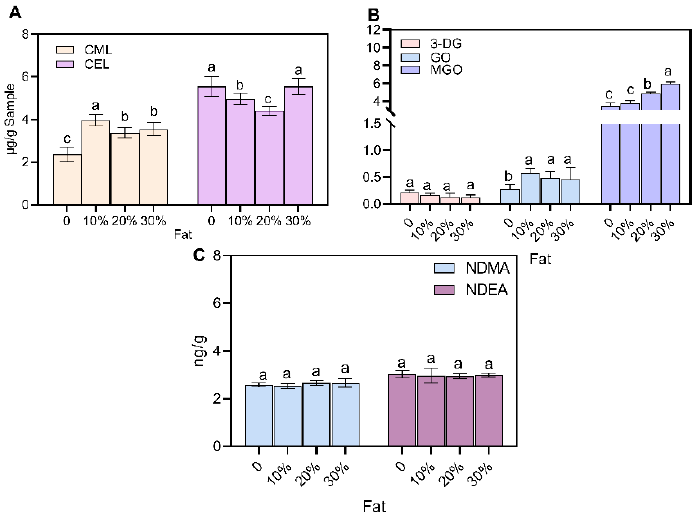
Figure 7. Effect of different ratios of fat addition on AGEs, α -dicarbonyl compounds and NAs: ( A ) AGEs; ( B ) α -dicarbonyl compounds; ( C ) NAs. Different letters above the bars indicate significant differences (n = 3, p < 0.05). Advanced glycation end products (AGEs), N-nitrosamines (NAs), N ε -carboxymethyl lysine (CML), N ε -carboxyethyllysine (CEL), methylglyoxal (MGO), glyoxal (GO), 3-deoxyglucuronide (3-DG), N-nitrosodimethylamine (NDMA) and N-nitrosodiethylamine (NDEA).